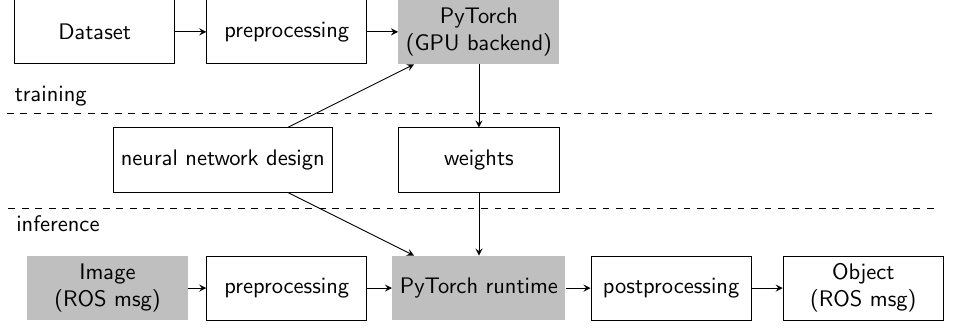
Figure 3. Object detection training and inference